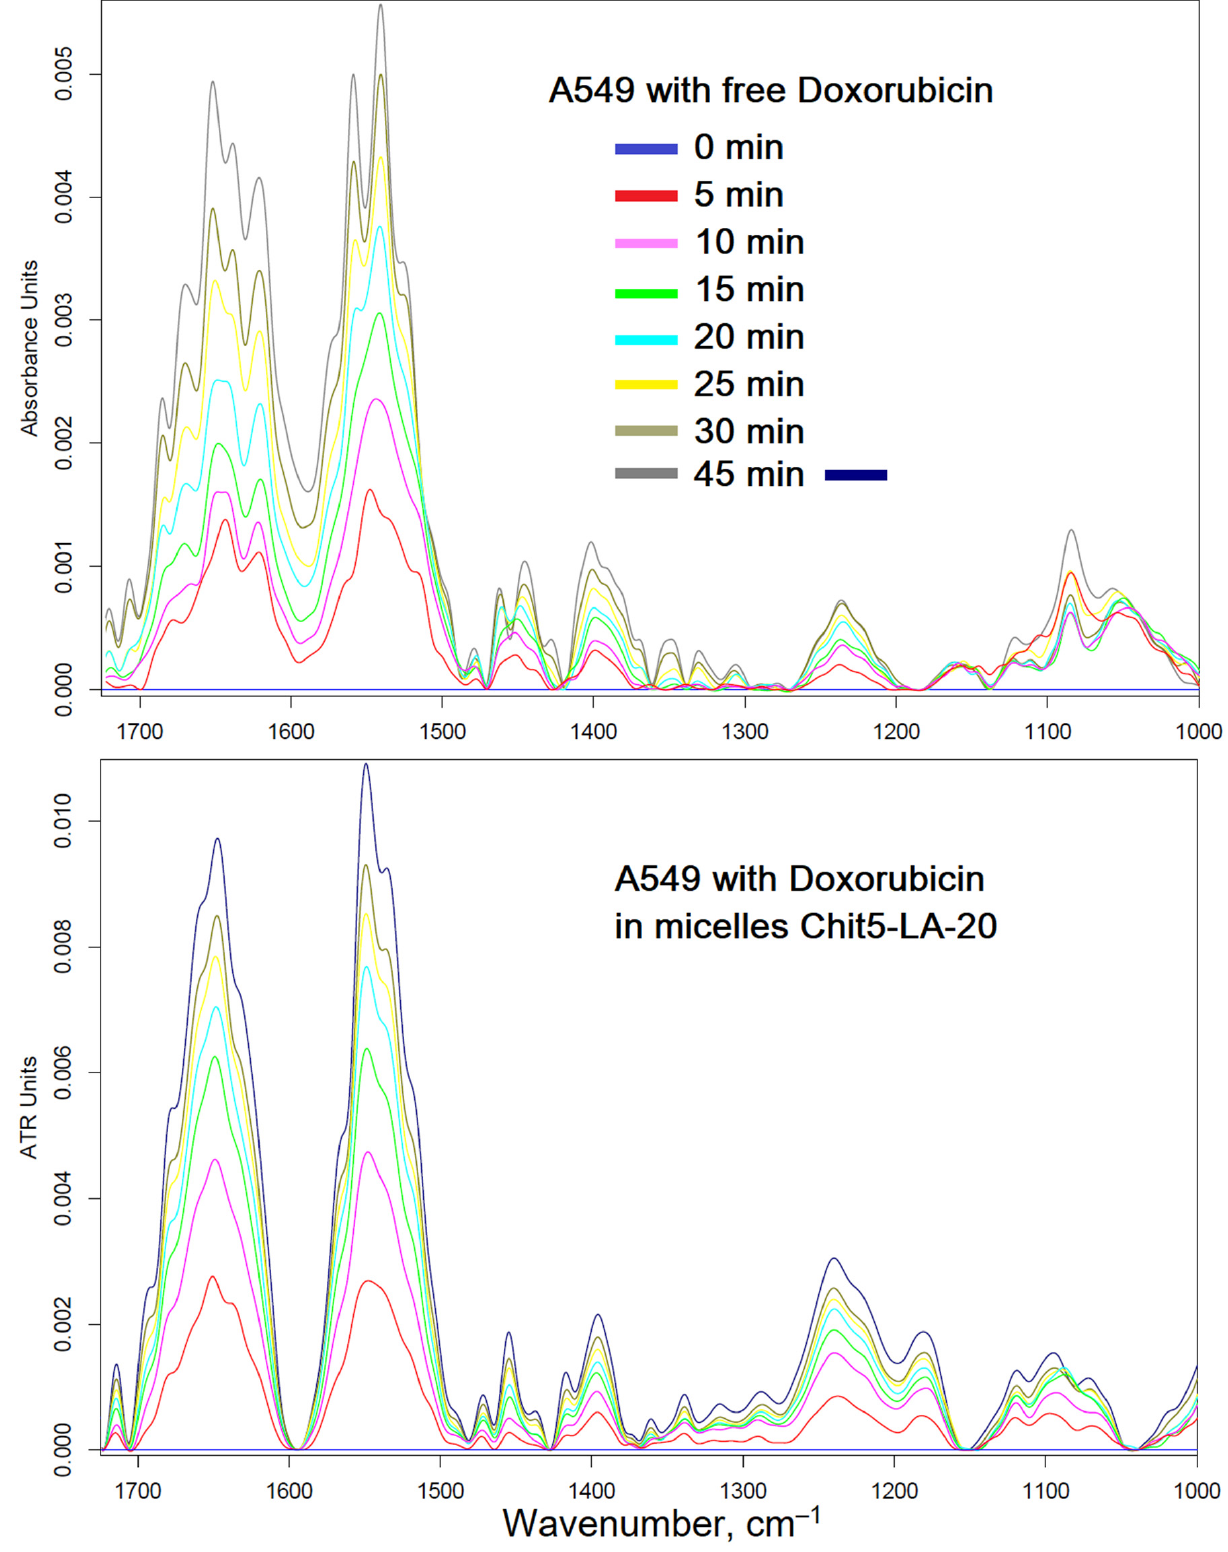
Figure 10. Difference FTIR spectra of cancer A549 cells during incubation for 45 min with doxorubicin (0.1 mg/mL) in free form or in micellar form (polymer:Dox = 1:2 w / w ). pH = 7.4 (PBS, 0.01 M). T = 37 °C.